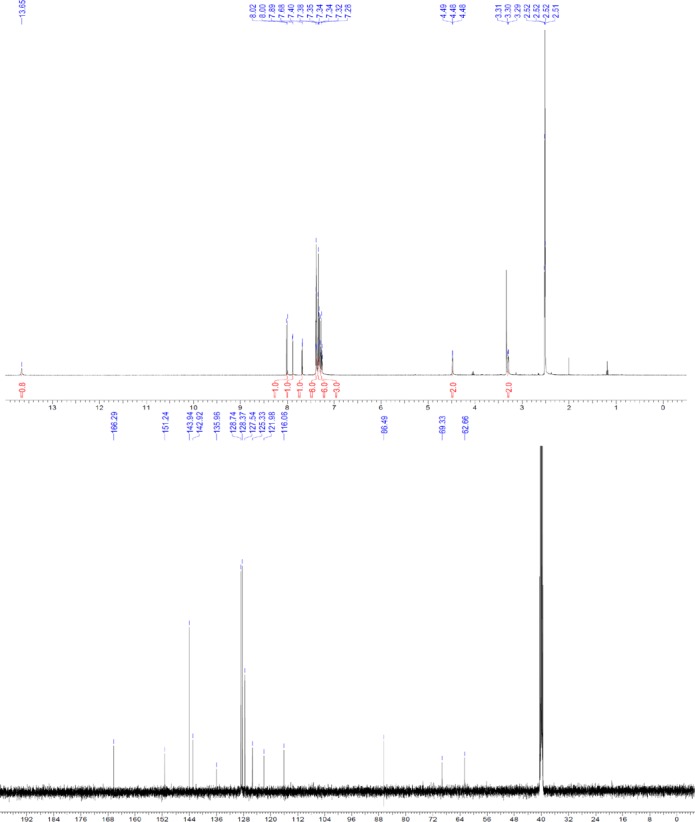
1H and 13C NMR of compound 3 g.